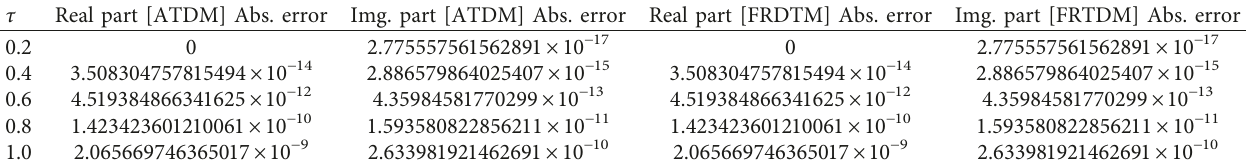
Table 2: The absolute error in ATDM and FRDTM for Example 2 at ] � 2.